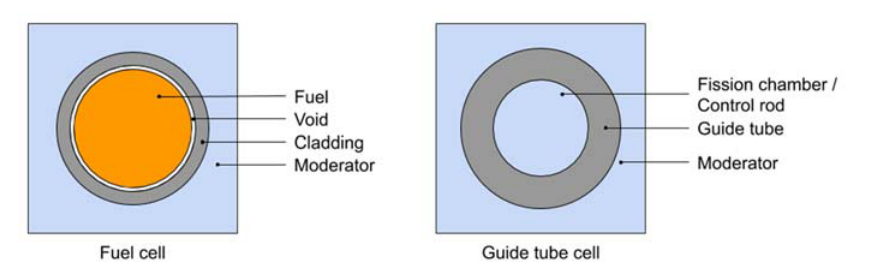
Figure 1. Modified pin cell